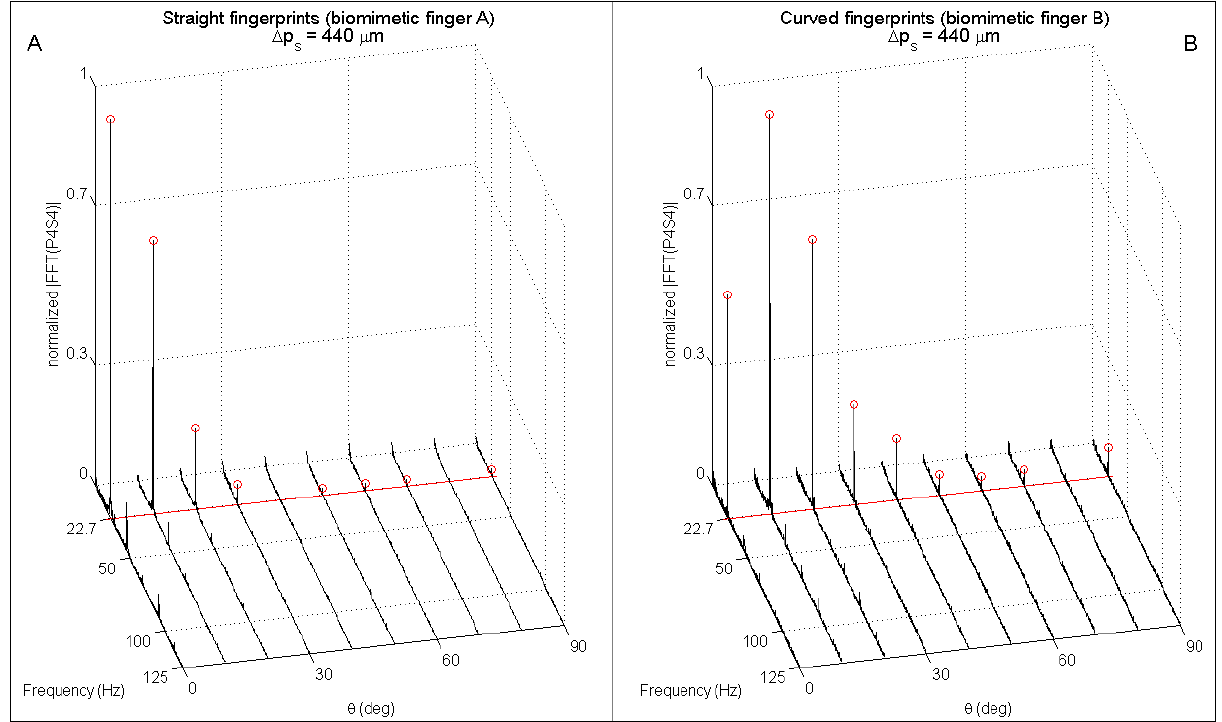
Figure 9. Single-sided normalized amplitude spectra as a function of the rotation of the biomimetic fingertip with straight ( Panel A ) and curved ( Panel B ) fingerprints. Data is related to 4.096 s subsets gathered from Piezoresistor 4 of Sensor 4 (P4S4) while the stimulus was indented and rubbed tangentially to the finger. Normal stimulus-fingertip contact force was set to 200 mN, while the sliding velocity was 10 mm/s. According to Equation (1), the expected principal frequency (marked with a red straight line) was 22.7 Hz. The red circles highlight the correctly identified (by applying Equation (2)) peak frequency per each stimulation combination . Higher isotropy as a function of the rotation angle is appreciated with the fingertip having curved